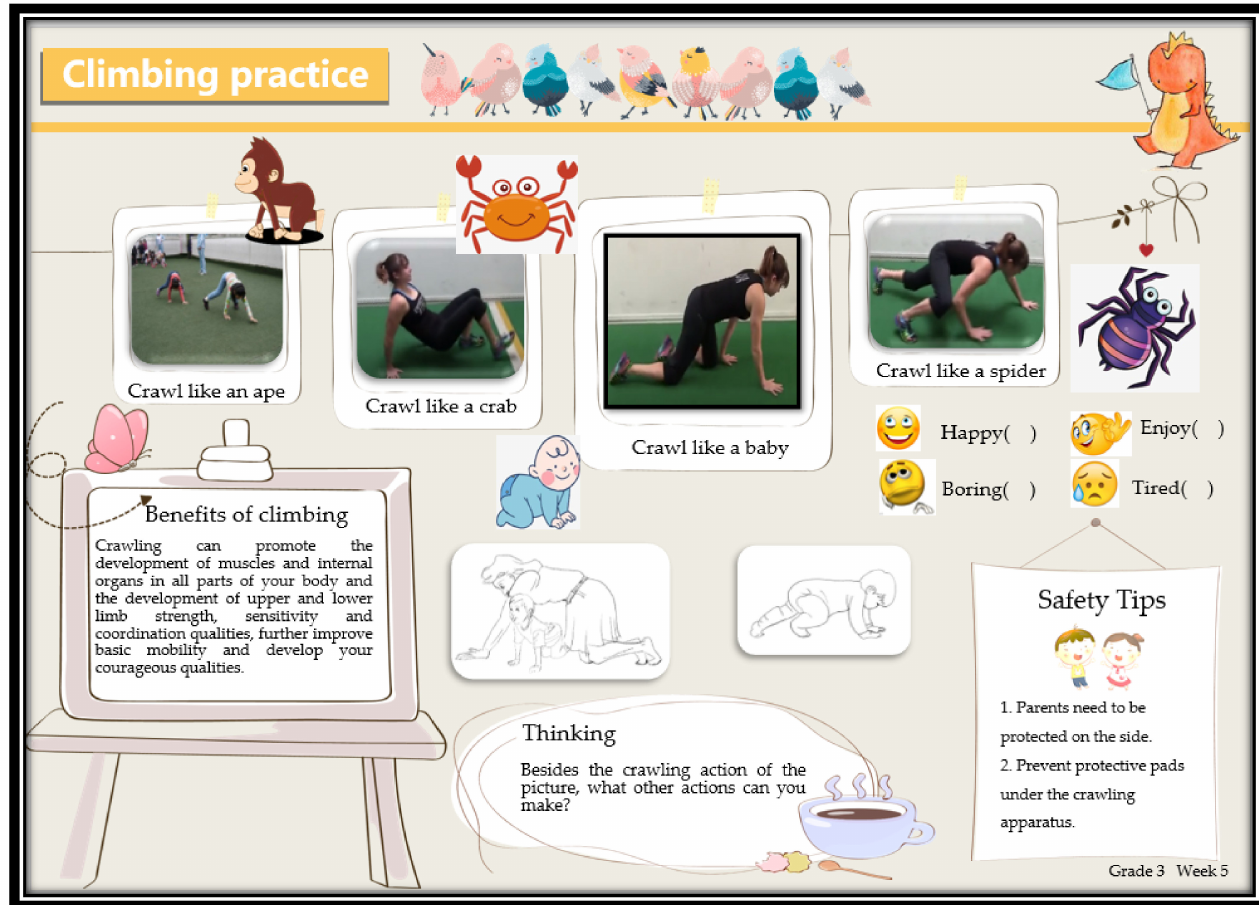
Figure 3. Contents of the third-grade week 5 flipchart. Crawling practice topics (introduction to the benefits of crawling, demonstration of various forms of crawling practice, safety and protec- tion